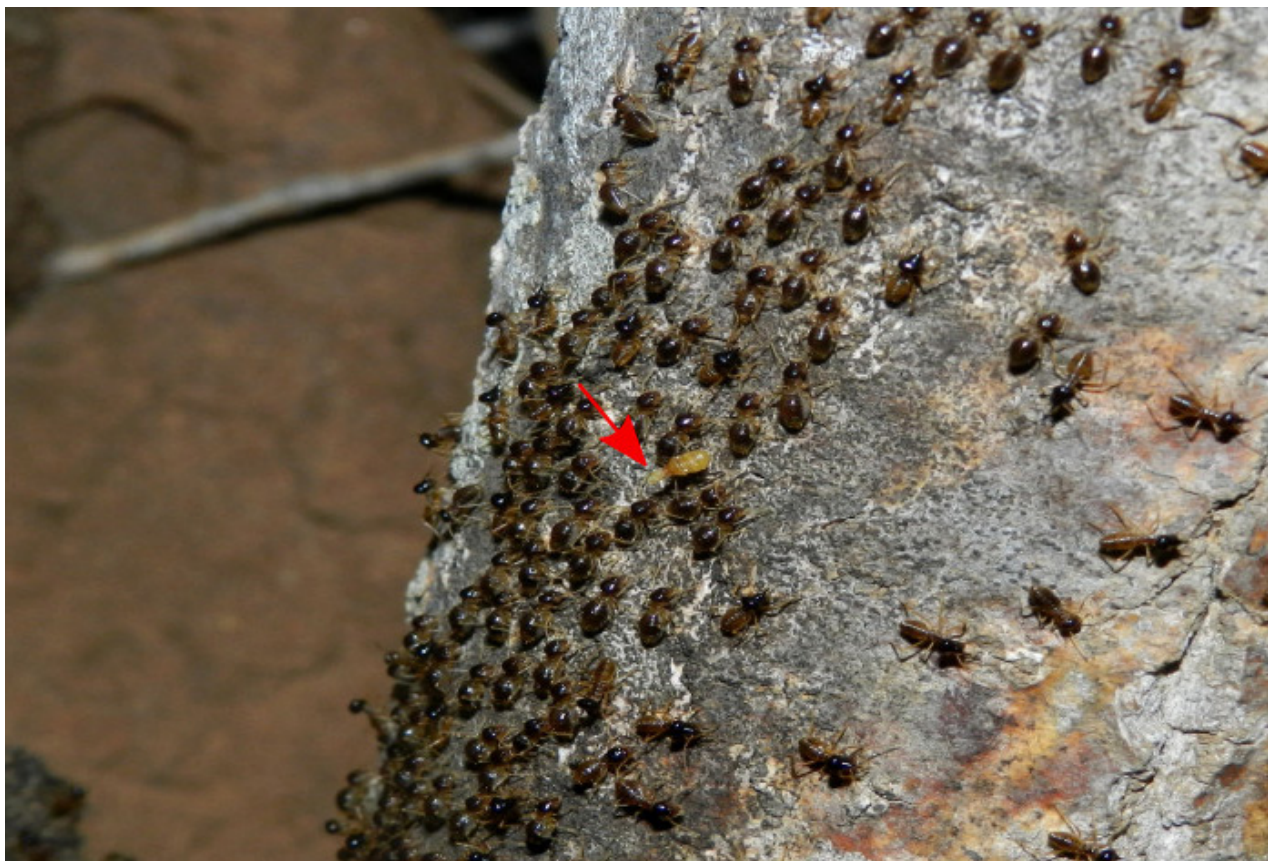
Fig 1 . Female of Corotoca sp. releasing its larva during the foraging of its host Constrictotermes cyphergaster